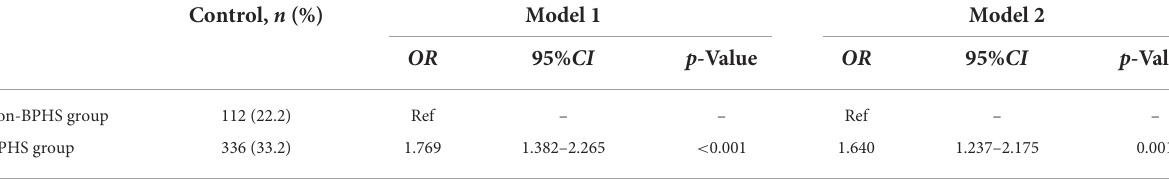
TABLE 2 Unadjusted and adjusted models: association of BPHS with control of